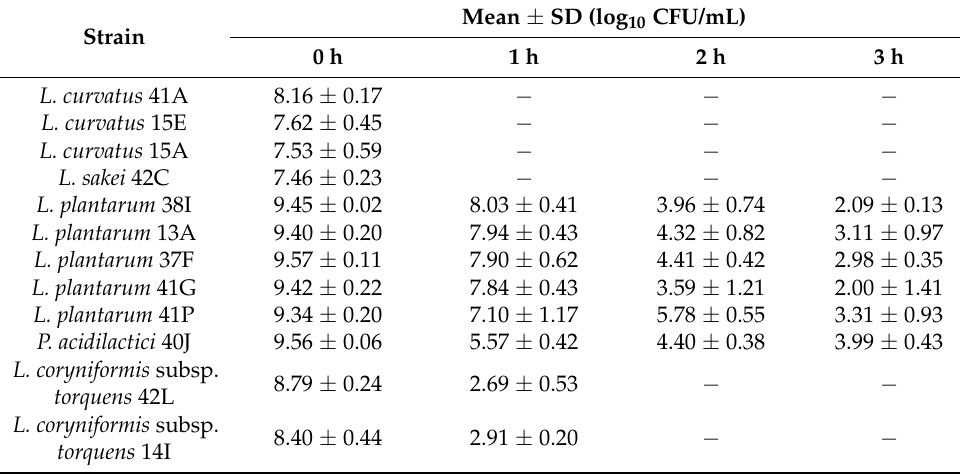
Table 5. Survival of selected LAB isolates under simulated gastric juice conditions at 37 ◦ C. Results presented as mean ± SD from three independent experiments. No survival was presented as ‘ − ‘.